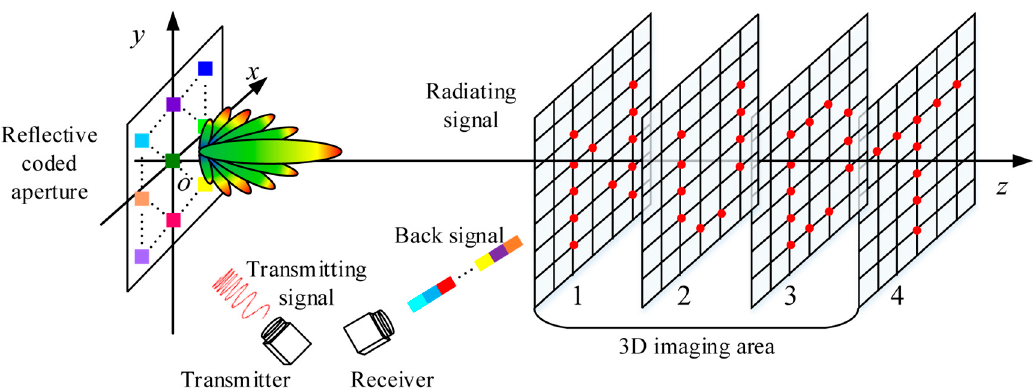
Figure 1. Schematic diagram of three-dimensional terahertz coded-aperture imaging (3D TCAI).